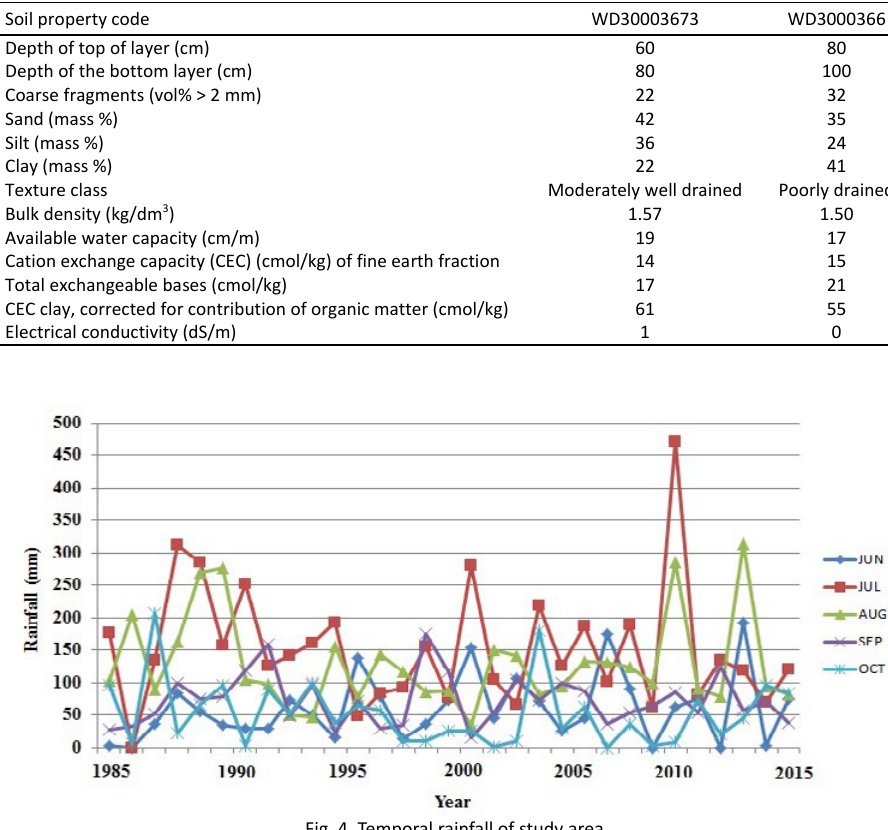
Table 3: Soil Properties of Malakand Table 3. Soil Properties of Malakand